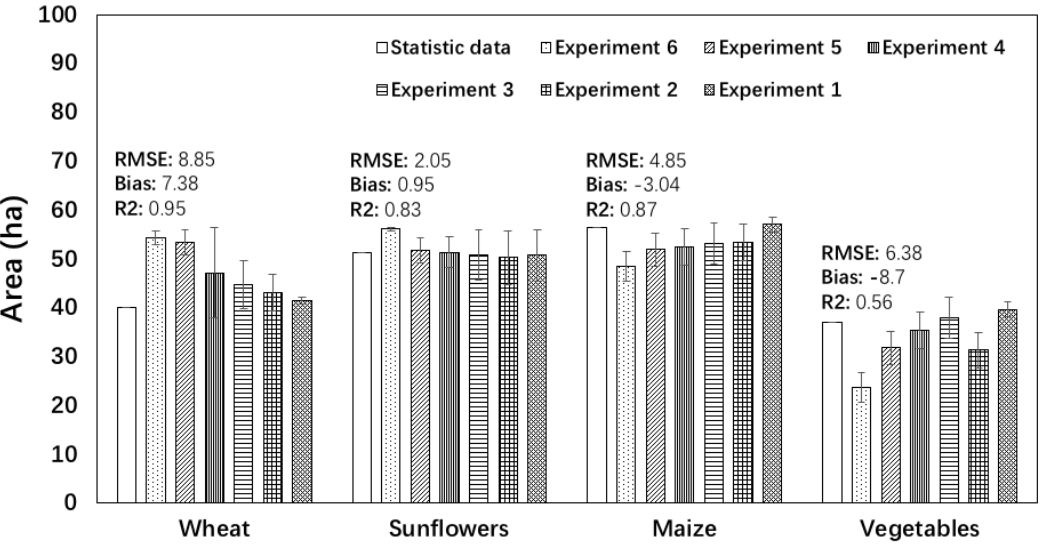
Figure 8. Comparison of the statistical data and the remote sensing estimated areas for wheat, sunflowers, maize, and vegetables.